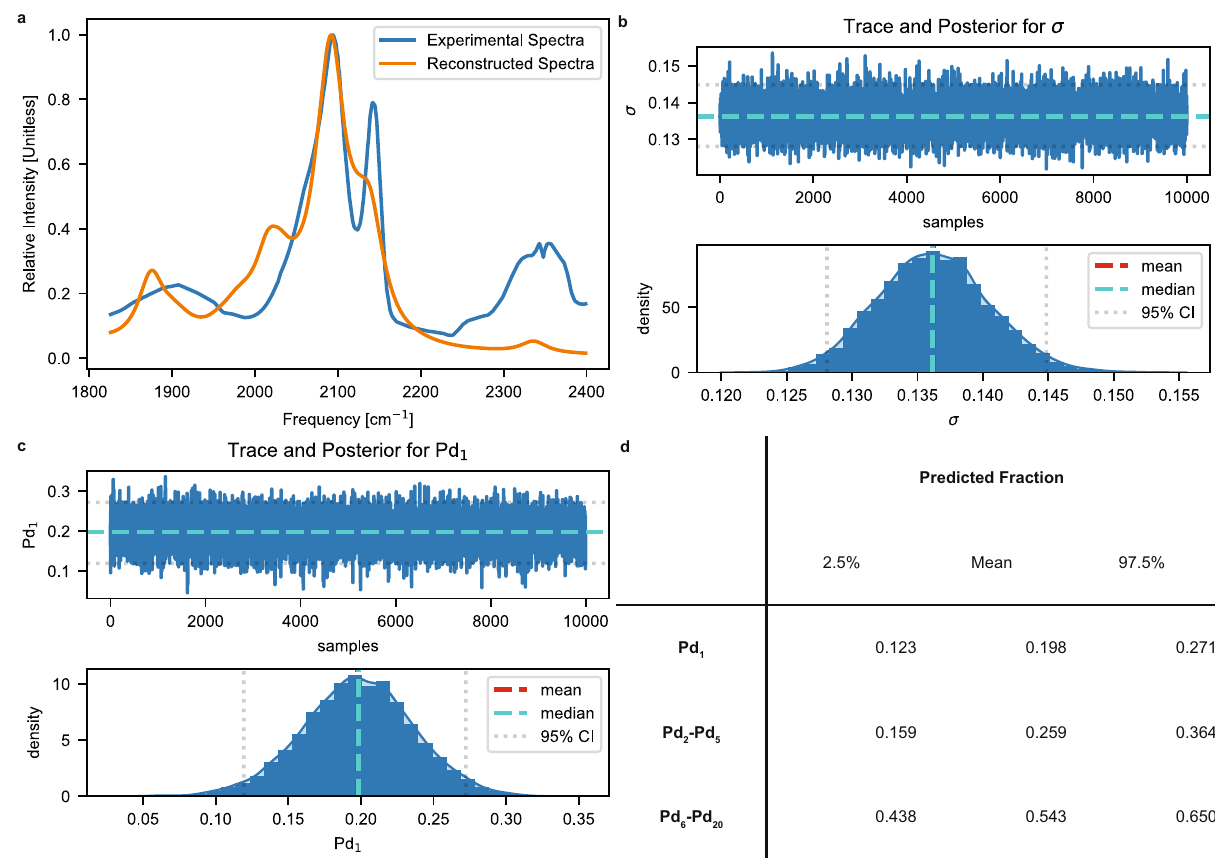
posterior distribution plots for Pd 1 . d Means and 95% credible intervals (CI) of the predicted concentrations for Pd 1 and bins of Pd 2 -Pd 5 , as well as Pd 6 -Pd 20 . We choose these bins as the former contains monolayer clusters and the latter bilayer (or larger)